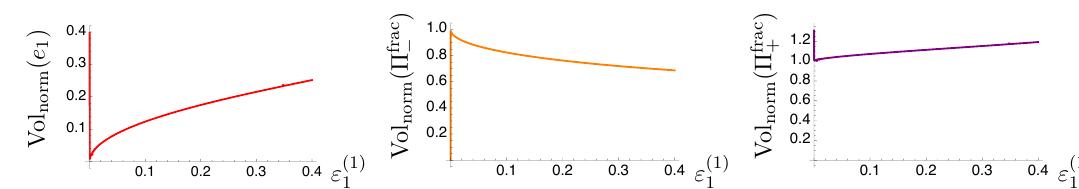
on T 4 = Z 6 and the 1 (1)